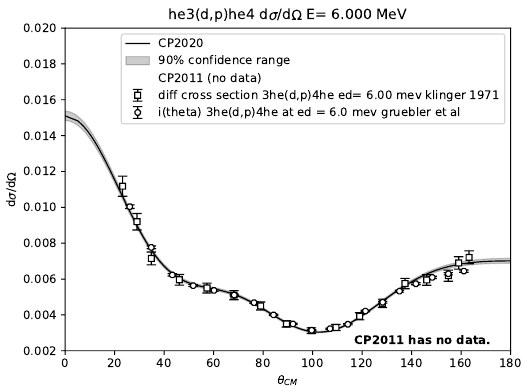
Figure 6. The angular distribution for 3 He( d , p ) 4 He for deuteron incidentlaboratoryenergy6.0MeVoftheunpolarizeddifferential cross section in the center of mass as a function of the center of mass angle θ cm . The evaluation is shown by the solid curve. The gray band is the 90% confidence interval determined as described in the text.